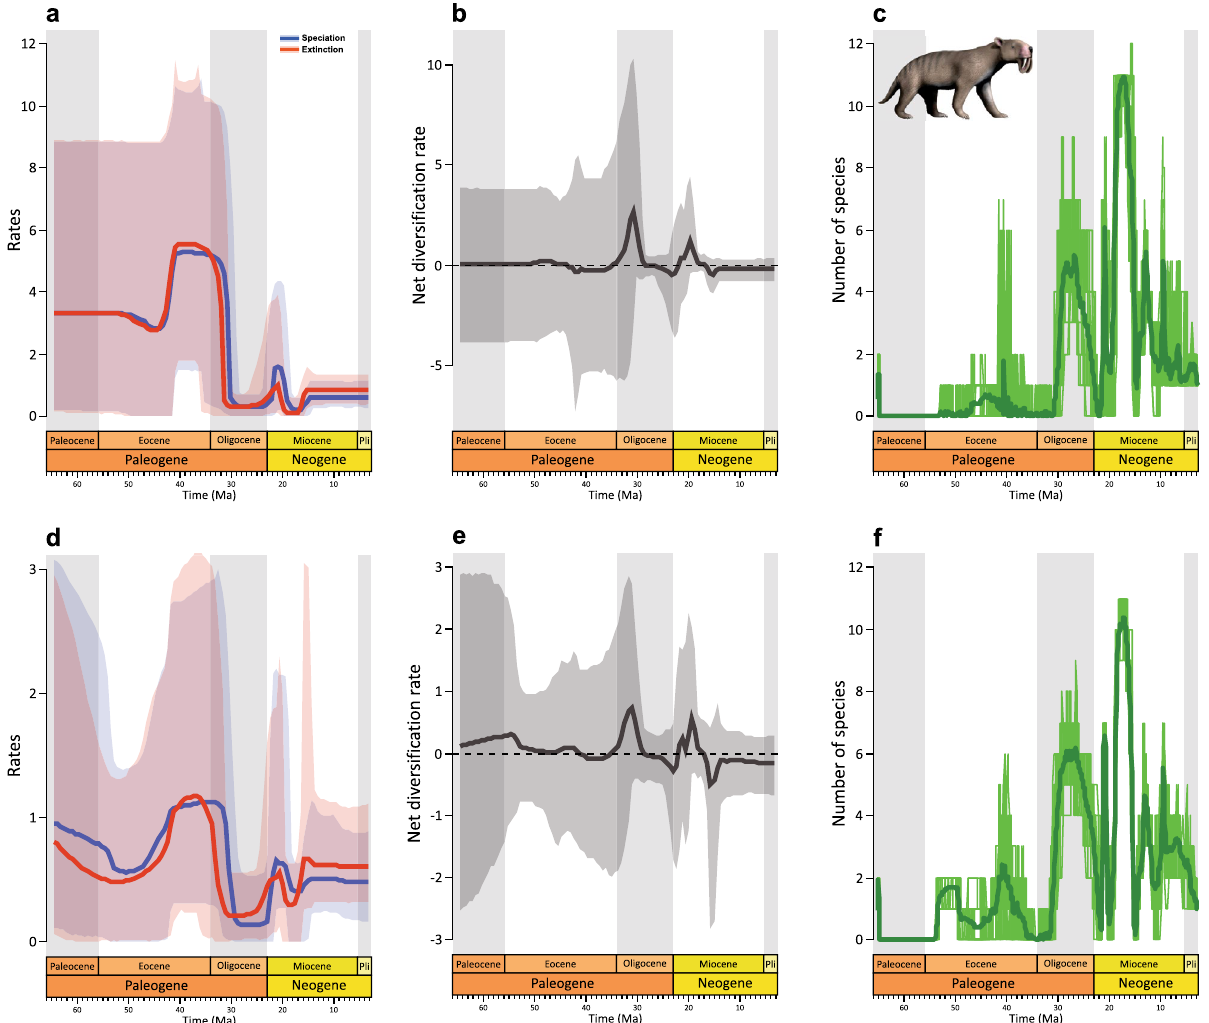
Figure 1. The rise and fall of Sparassodonta throughout the Cenozoic. The Bayesian estimates of speciation (blue), extinction (red), net diversification (grey, speciation minus extinction) rates, and diversity based on species occurrence dataset ( a – c ) and fossil specimens dataset ( d – f ). Solid lines indicate mean rates, and the shaded areas show 95% credible intervals. Thylacosmilus atrox designed by Nobu Tamura